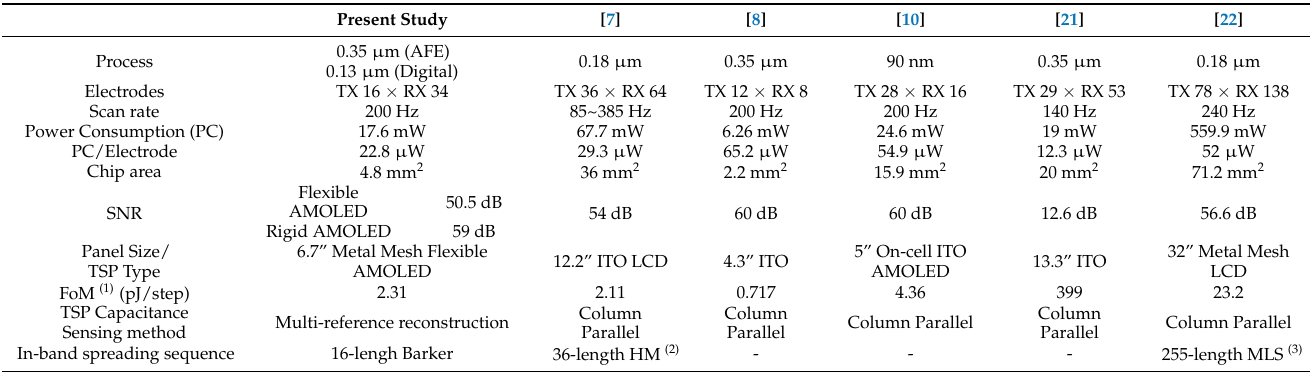
Table 1. Performance summary and Comparison to Previous Works.